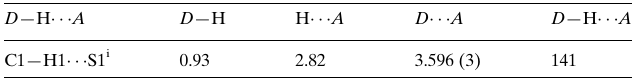
Hydrogen-bond geometry (A˚ , (cid:4)